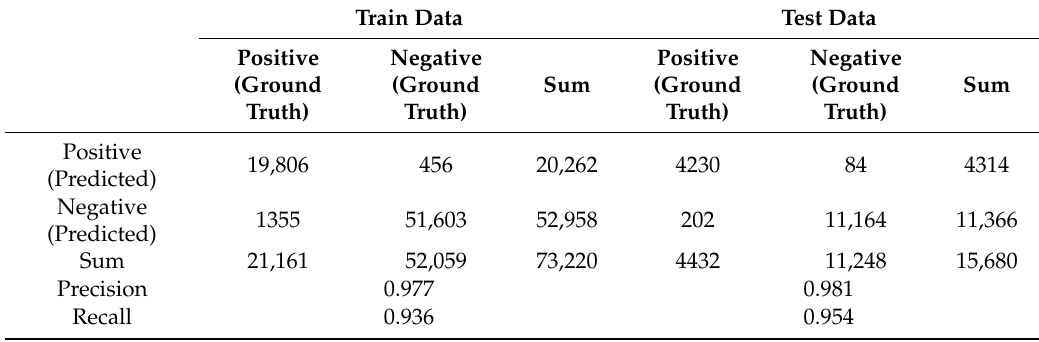
Table 1. The precision and recall of the proposed autoencoder to identify the presence and absence of vehicles on the virtual detection